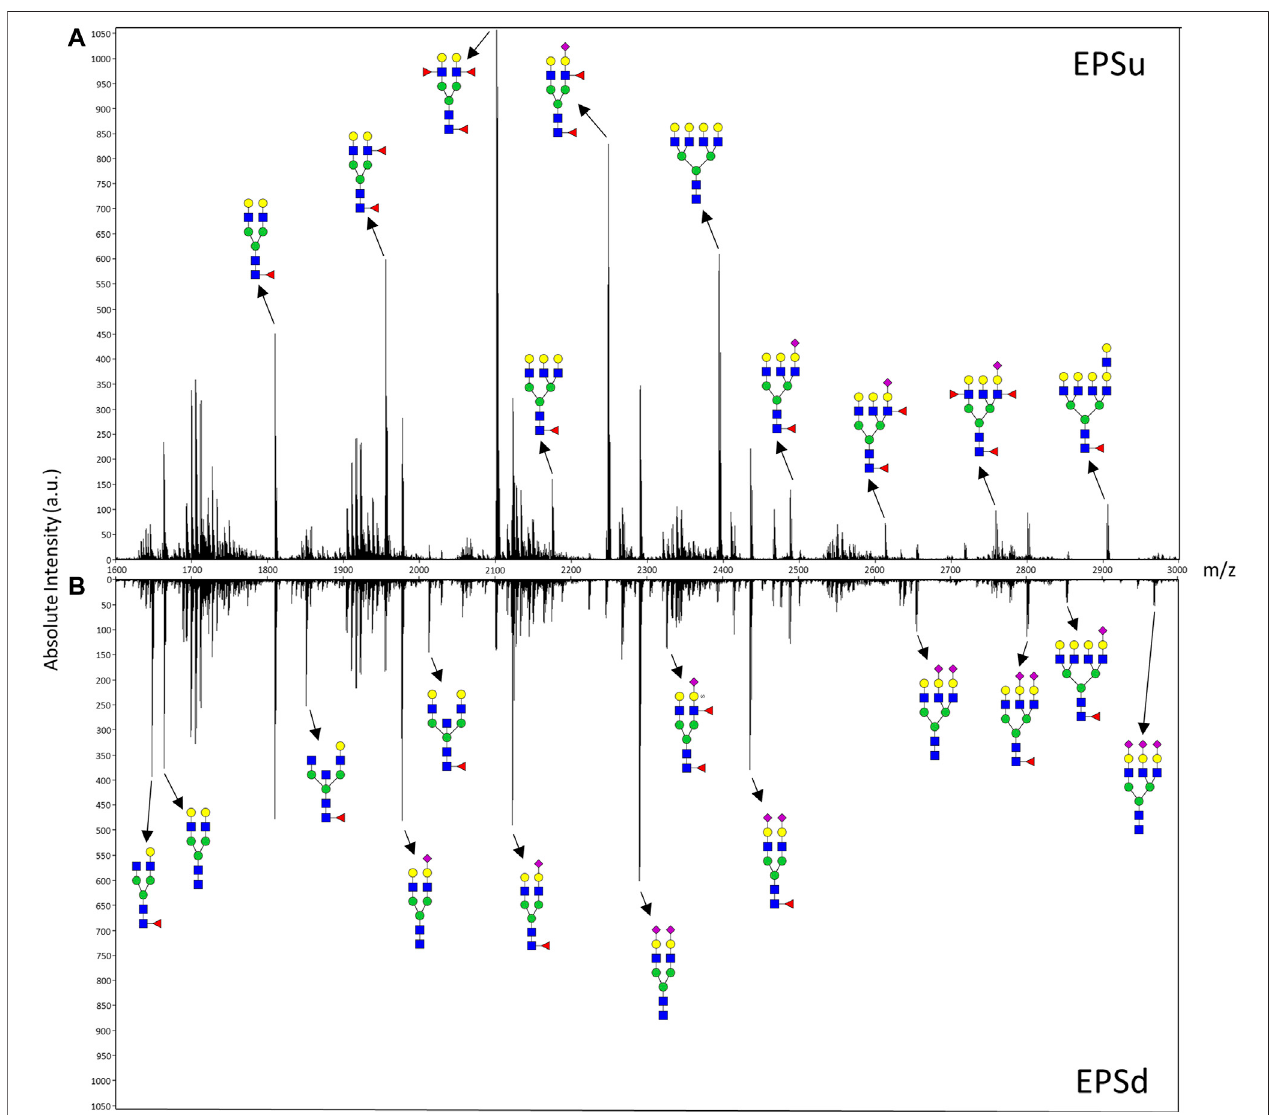
FIGURE3| MassspectraofrepresentativeEPSu (A) and EPSd (B) sampleswithannotationsforaset ofputative N-glycan structures.TheN-glycan compositions arerepresentedbybluesquaresfor N -acetylglucosamine,greencirclesformannose,yellowcirclesforgalactose,purplediamondsforsialicacid,redtrianglesforfucose, and an “ S ” for